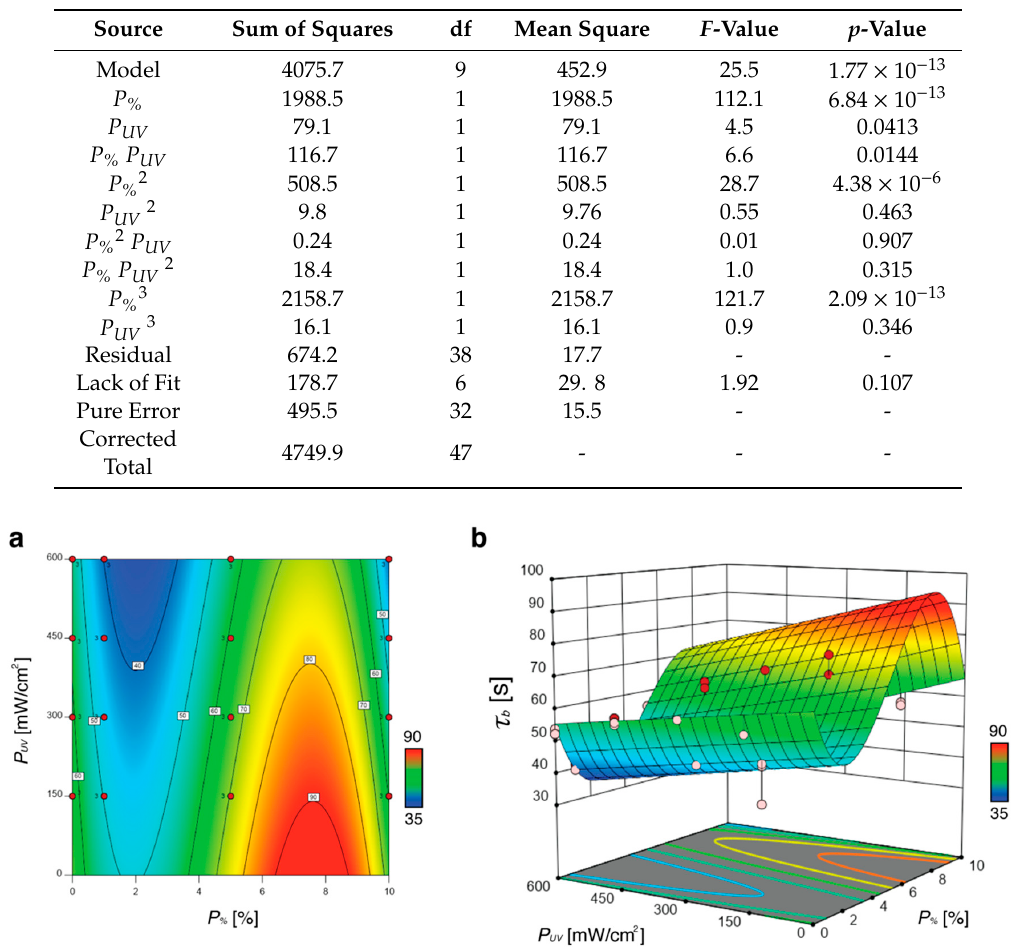
Table 8. ANOVA results for the τ b parameter in the complete cubic model for photo-bending.